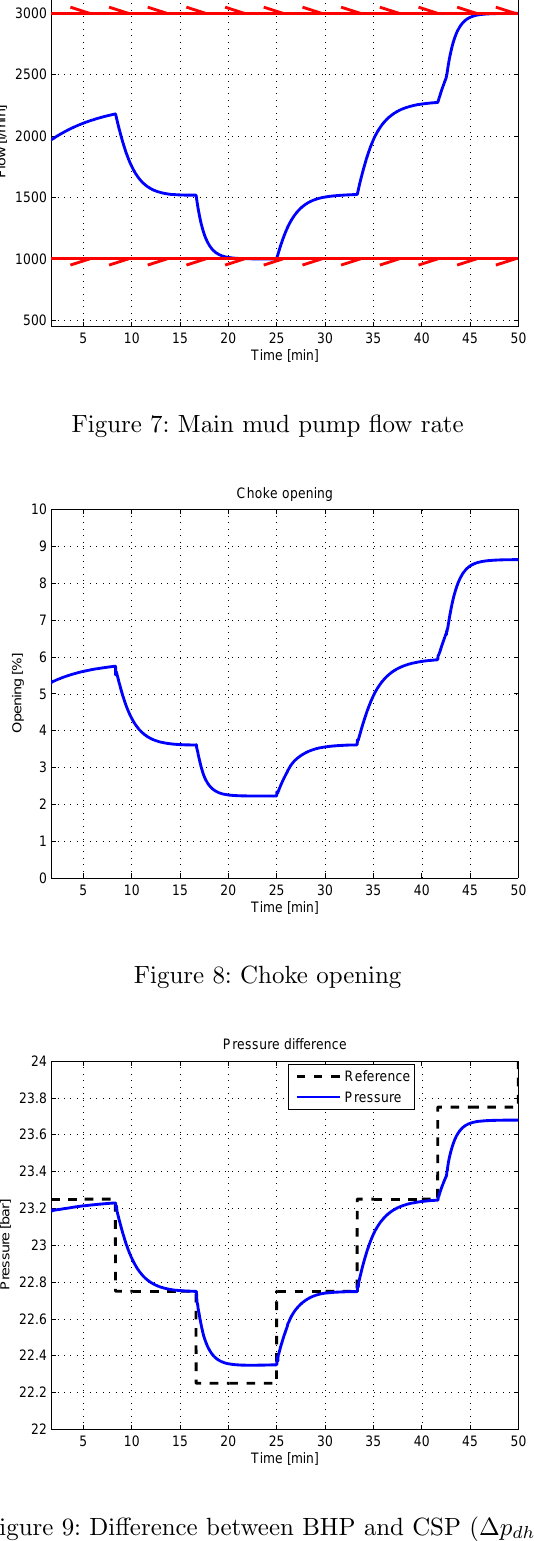
Figure 9: Difference between BHP and CSP (∆ p dh